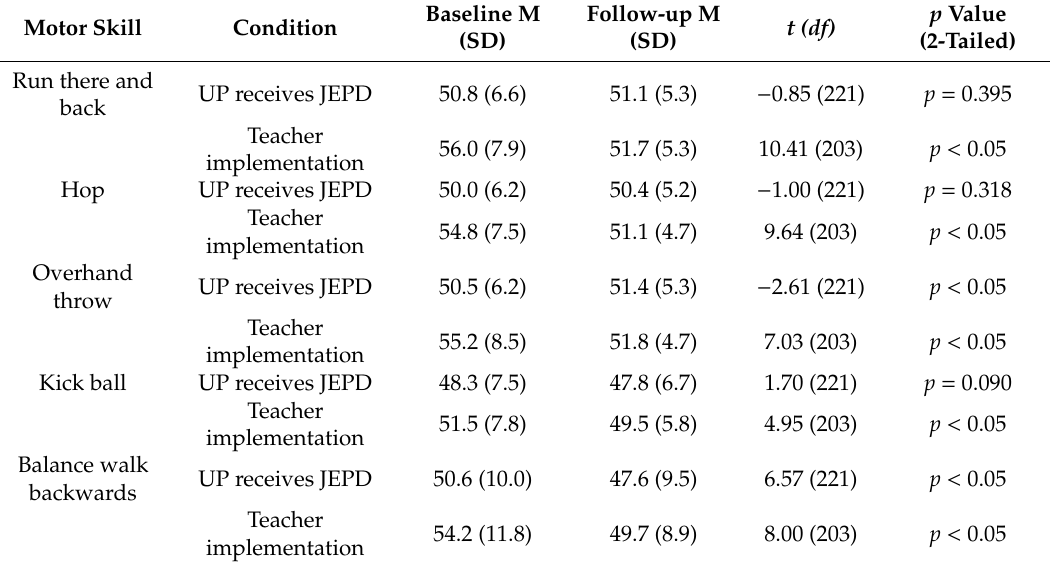
Table 9. Paired samples t -test between baseline and follow-up for usual practice that received JEPD and for the teacher implementation